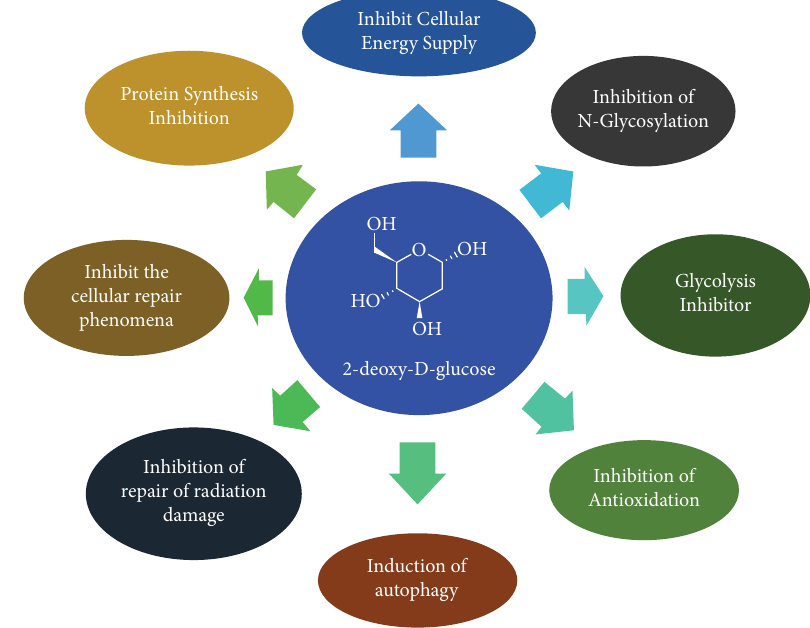
Figure 2: Pharmacological activities of 2-DG.